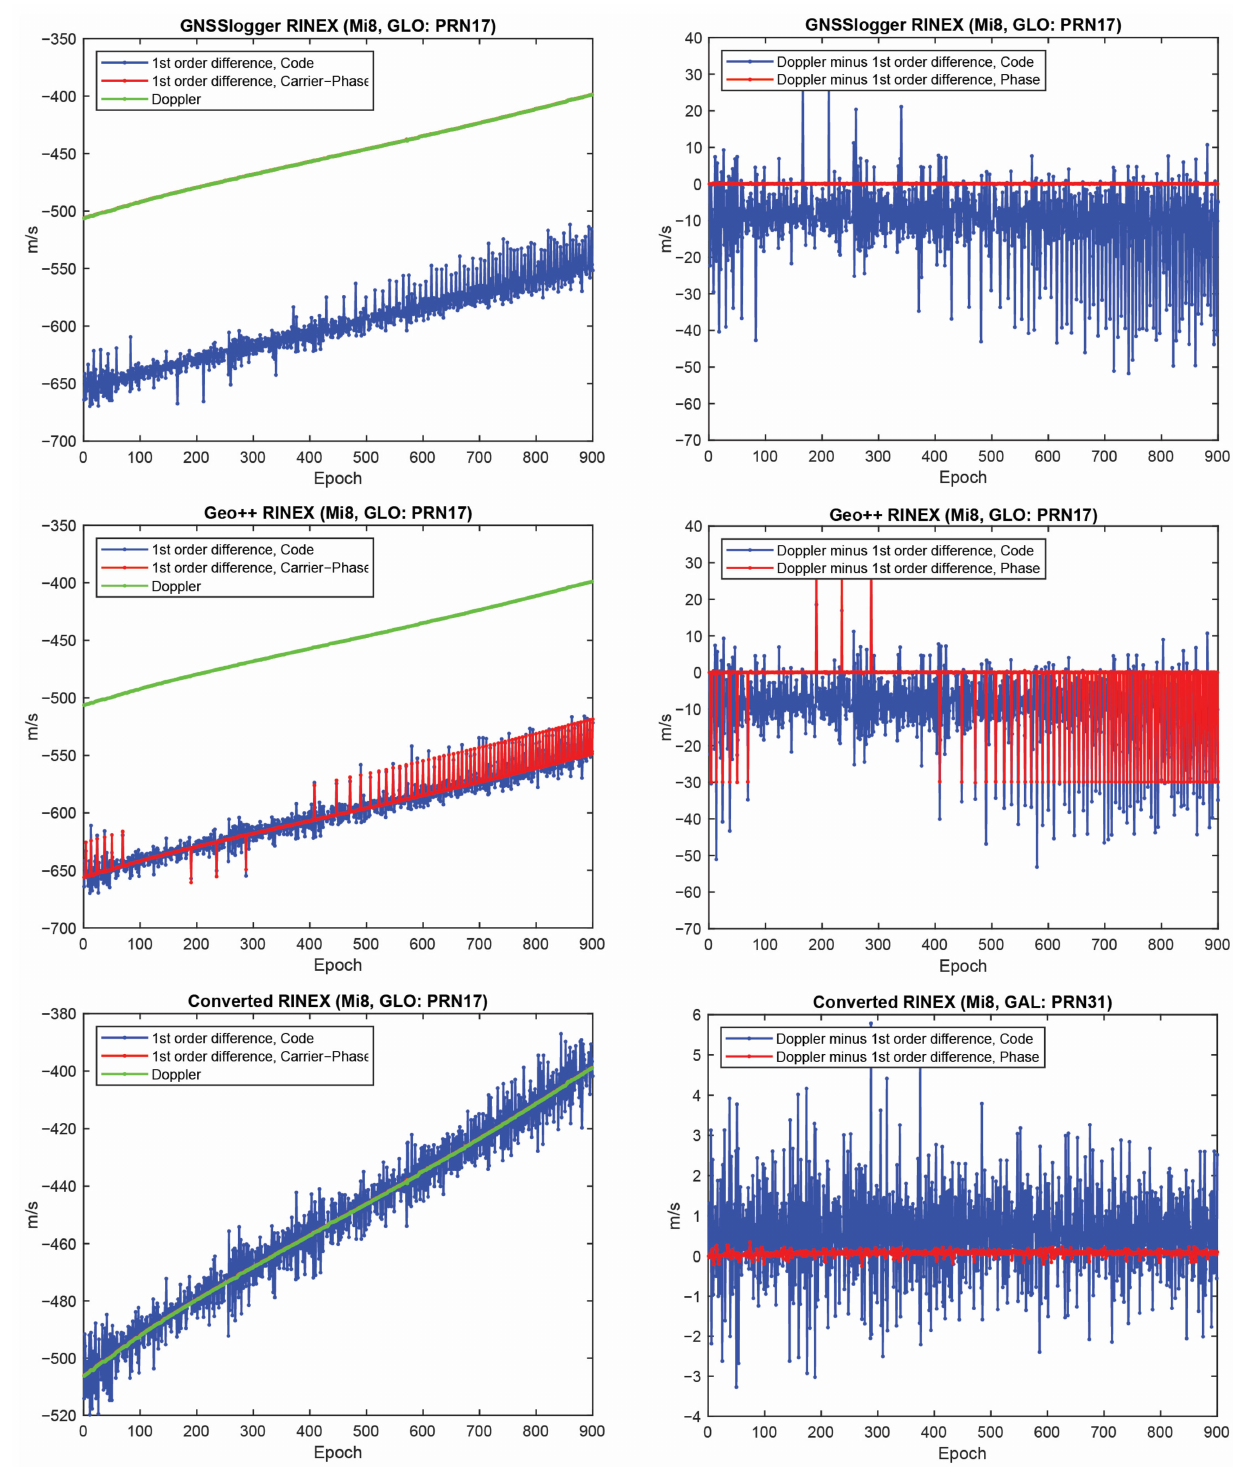
Figure 3. First-order differentiation of GLONASS pseudorange and carrier-phase observations as well as Doppler observations on L1 frequency for PRN 17 (Xiaomi